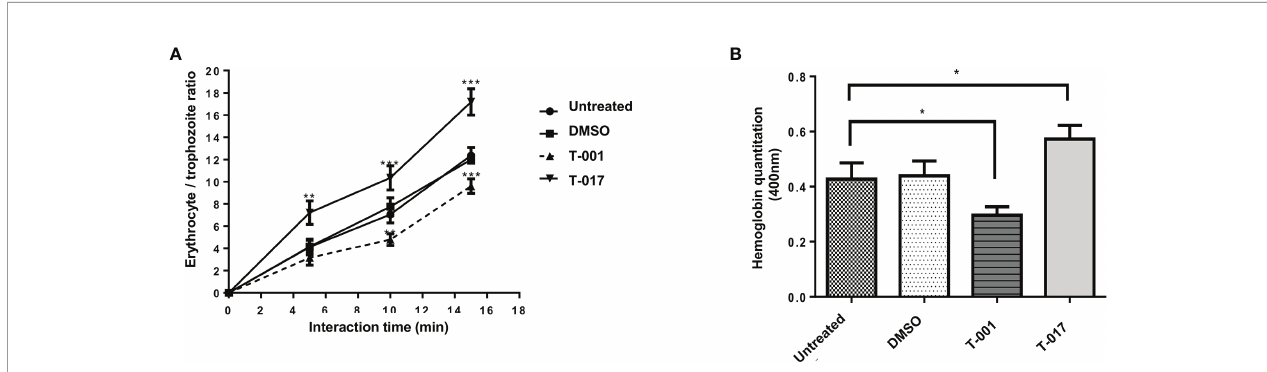
FIGURE 4 | Erythrophagocytosis of E. histolytica trophozoites treated with T-001 and T-017. (A) Erythrophagocytosis rate at 0, 5, 10 and 15 min of interaction of erythrocytes and trophozoites previously treated with T-001 and T-017. (B) Hemoglobin quantitation after 10 min interaction of erythrocytes and trophozoites previously treated with T-001 and T-017 and untreated. Trophozoites treated with DMSO 0.01% and grown in standard condition were used as controls. Graphs show the mean ± standard error of three independent experiments. The comparisons between groups were carried out with the one way ANOVA test, p < 0.05 (*) p < 0.01 (**) p < 0.001 (***).